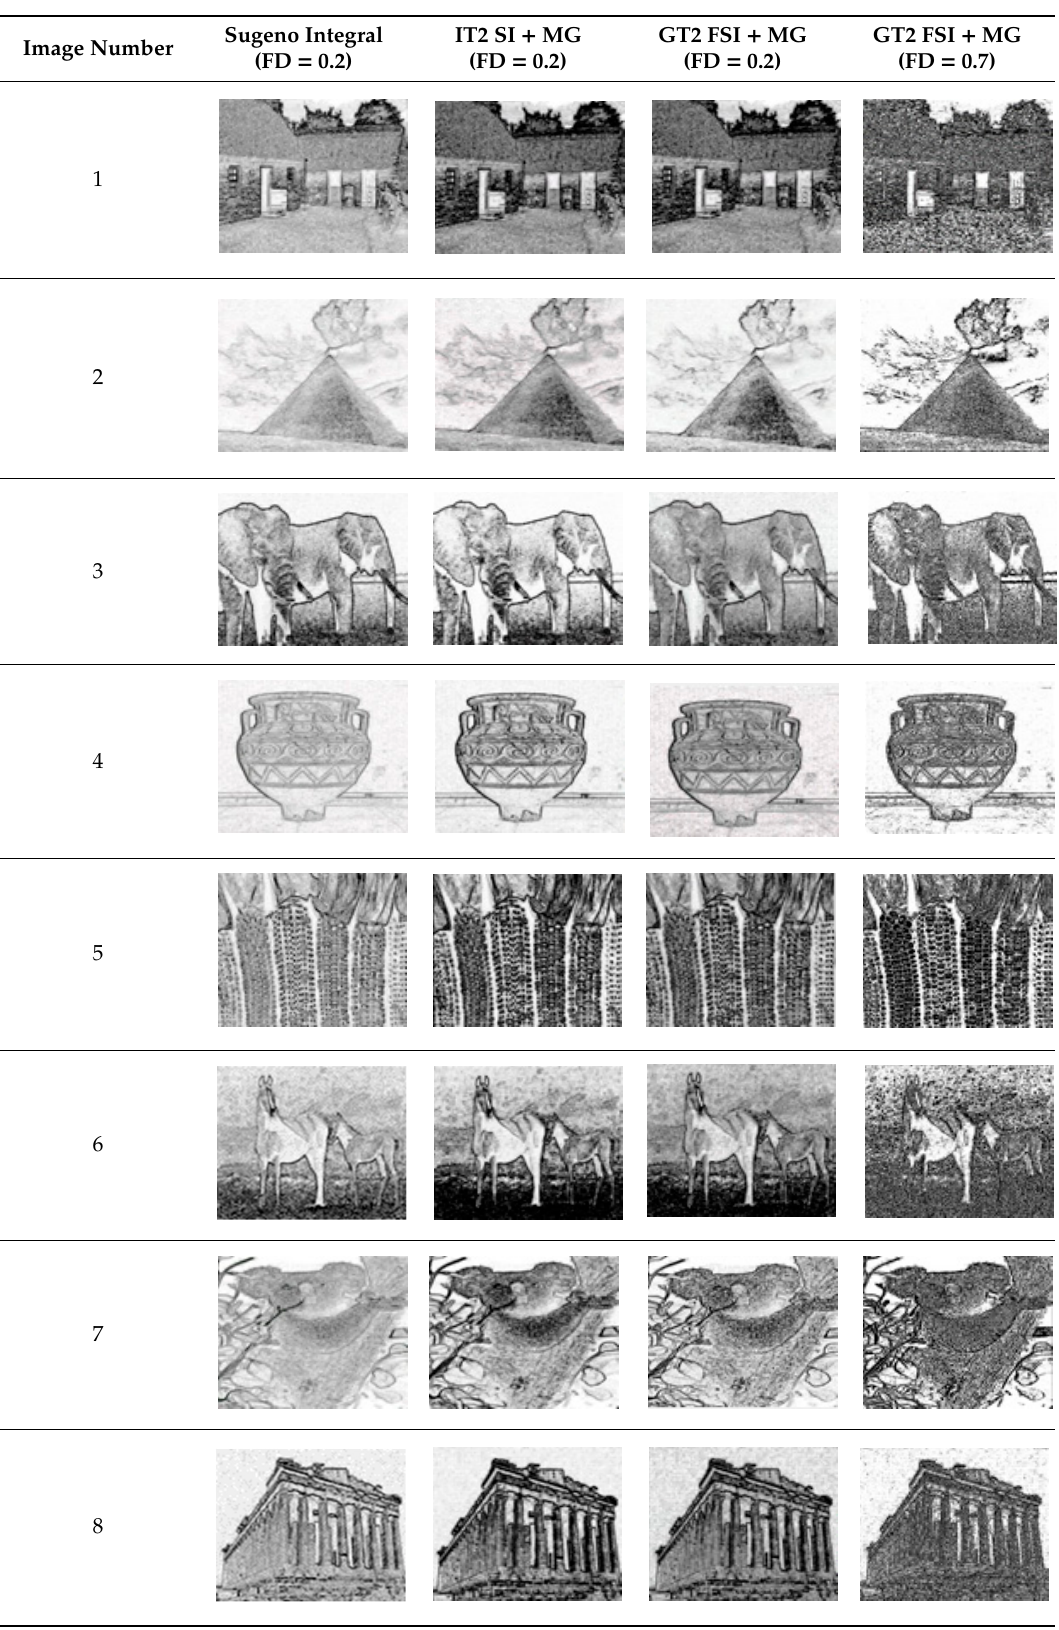
Table 11. The BSDS image database after implementing edge detectors.